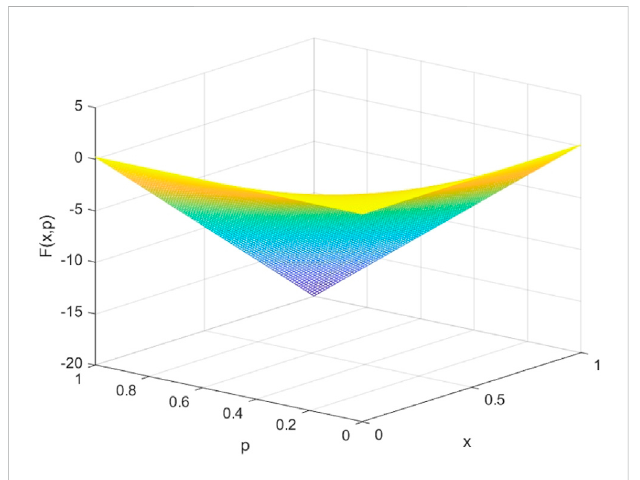
FIGURE 2 Simulation image of local government behavior strategy selection. FIGURE 3